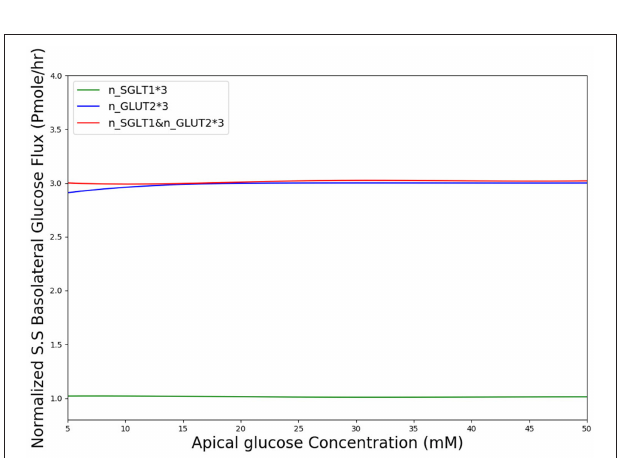
FIGURE 8 | Normalized steady state basolateral glucose flux vs. different stimulus of glucose in the lumen when number of SGLT1 is 3-fold higher(green), number of GLUT2 is 3-fold higher(blue) and number of both SGLT1 & GLUT2 are 3-fold